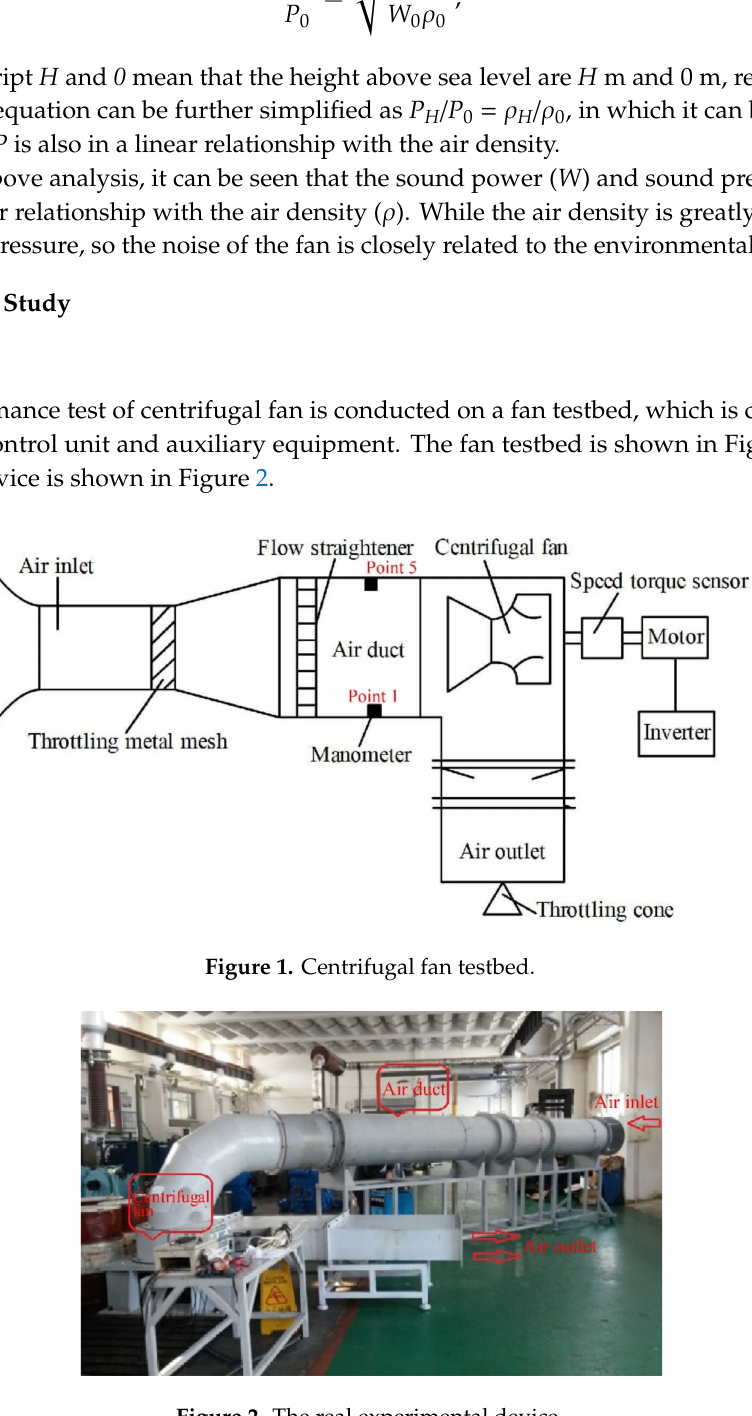
Figure 2. The real experimental